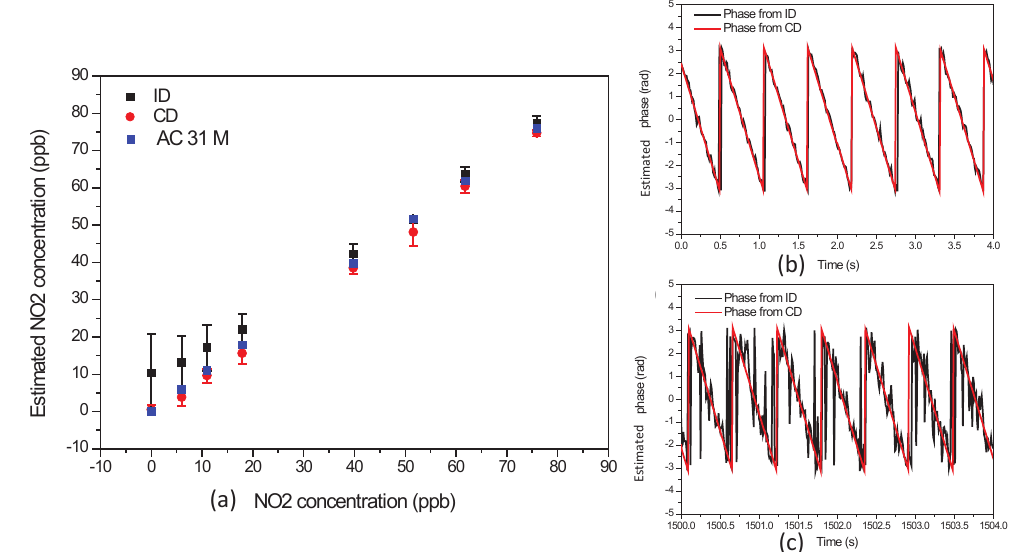
Figure 8. ( a ) Estimated NO 2 concentrations using ID and CD approaches with regards to the NO 2 concentration measured by AC-31M analyzer. The error bars are the root mean square error between the AC-31M measurements and the estimates obtained with the ID or CD methods; ( b ) Observed and estimated phase delay for a NO 2 concentration of 76 ppbv; ( c ) Observed and estimated phase delay for a NO 2 concentration of 6